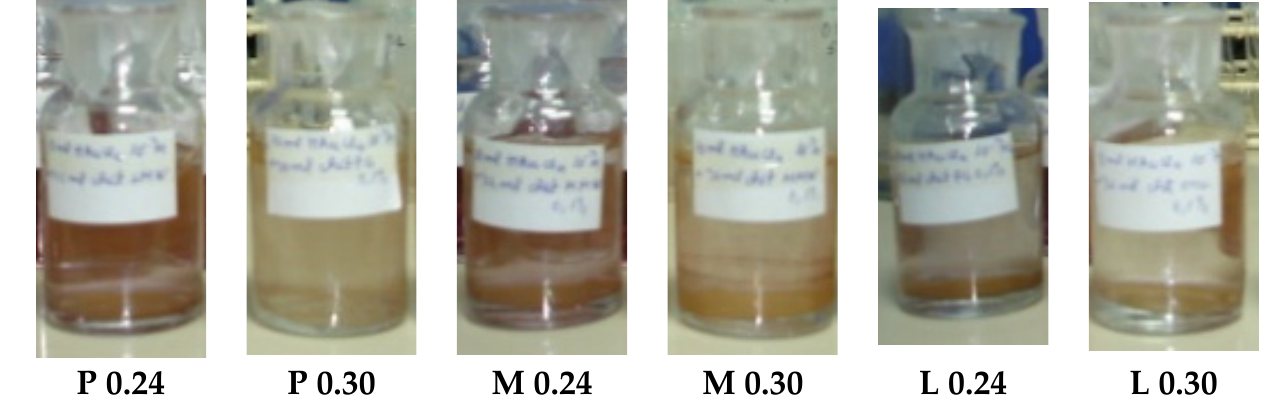
Figure 2. AuNP solutions with a concentration of 0.24 and 0.30 mM (unstable after a few weeks).